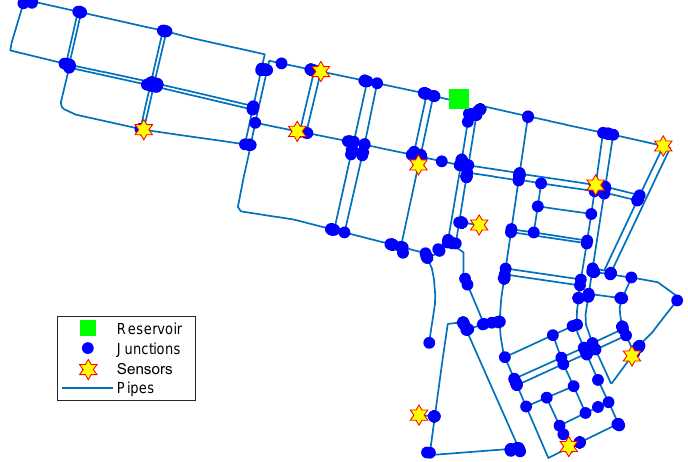
Figure 4. The optimal 10-sensor placement in a sector of the Madrid